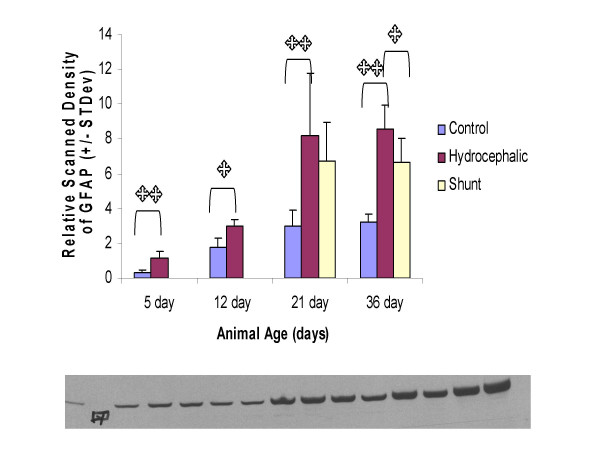
Scanning densitometry analysis of Western blots for GFAP in the parietal cortex. Above: Histogram of relative density. Overall, GFAP levels increased with age and with the progression of hydrocephalus, with significantly higher levels of GFAP being present in the 5d and 12d hydrocephalic animals. GFAP content also significantly increased over control in the 21d and 36d hydrocephalic animals. Shunting reduced GFAP levels from untreated hydrocephalic levels by 18% in the 21d shunted group (not significant). In the 36d group, there was a significant 23% decrease in the long term 36d shunted animals. Single asterisks indicates statistical significance at p < 0.05, double asterisk indicates significance at p < 0.01, brackets indicate comparison group. N = 5 for each group, values are means +/- standard deviation. Below: Immunoblot example showing clarity of bands, and standard in the left lane. The samples from the left are: lanes 3–7, 21 day control animal, 8–12, 21d shunted animals (shunted at 15d) and lanes 13–15, three of the 21d untreated hydrocephalic animals.